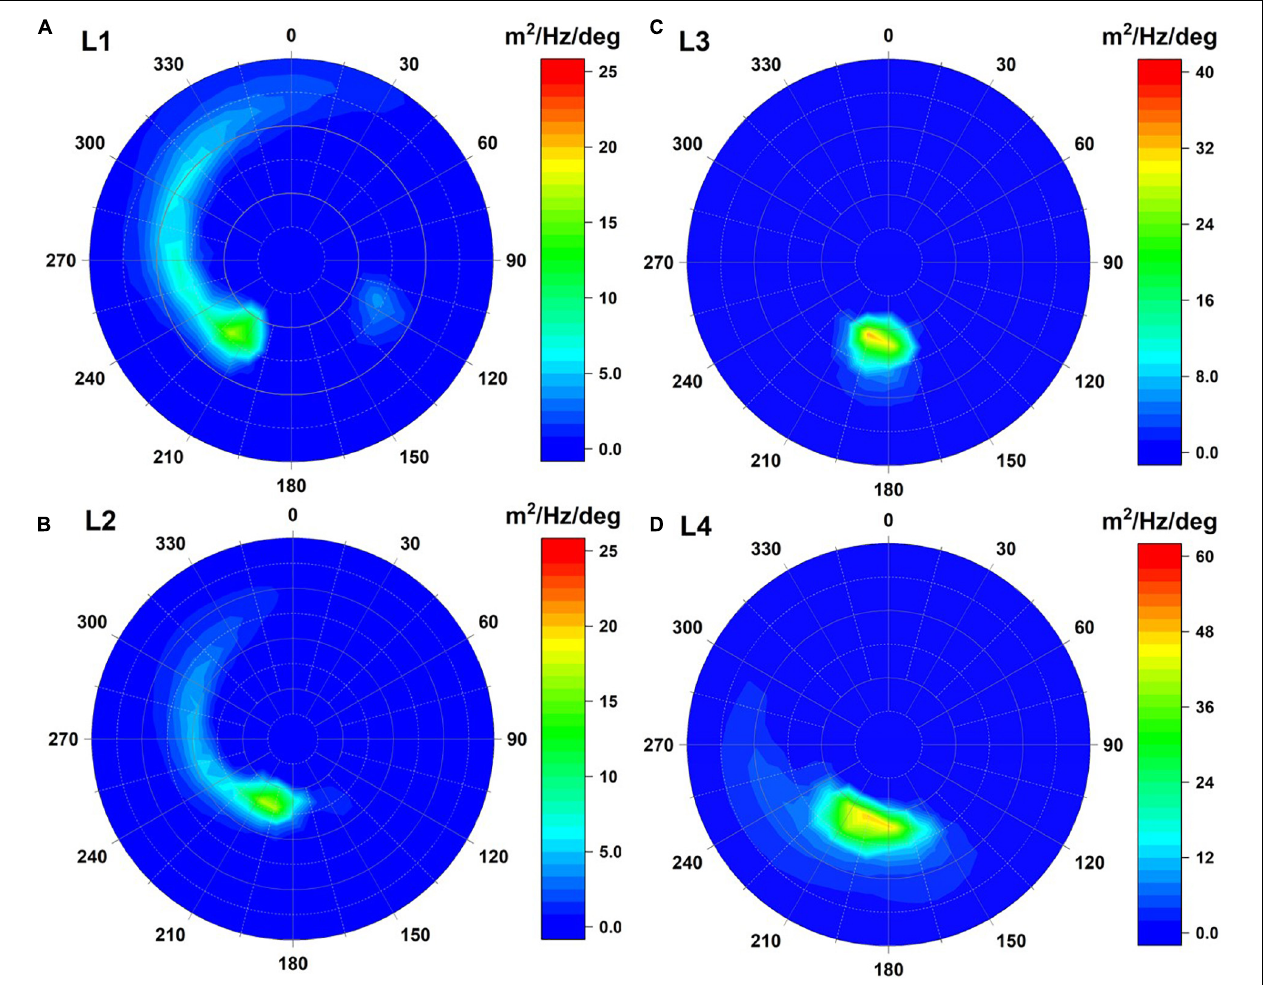
FIGURE 12 | Directional wave spectra generated by designed binary typhoons Maria (2018) and Meranti (2016) at (A) L1, (B) L2, (C) L3, and (D) L4 four selected representative points at the time of the peak significant wave during single Super Typhoon Maria (2018).